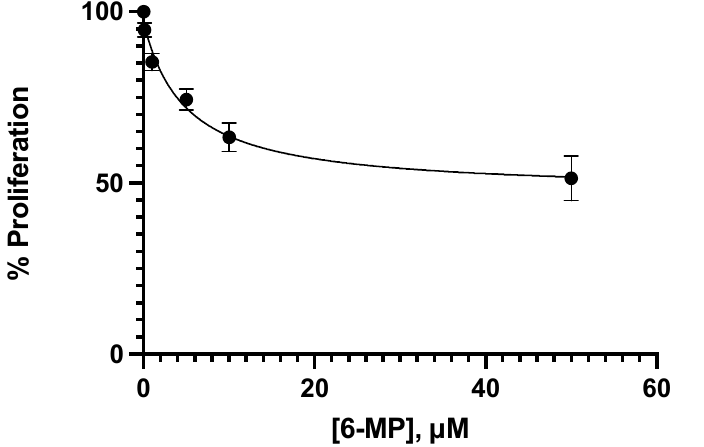
Figure 1. Concentration–response of 6-MP tested in Jurkat cells to study the effect on the cell proliferation at 24 h of treatment. Mean +/ − SE are shown in each point.